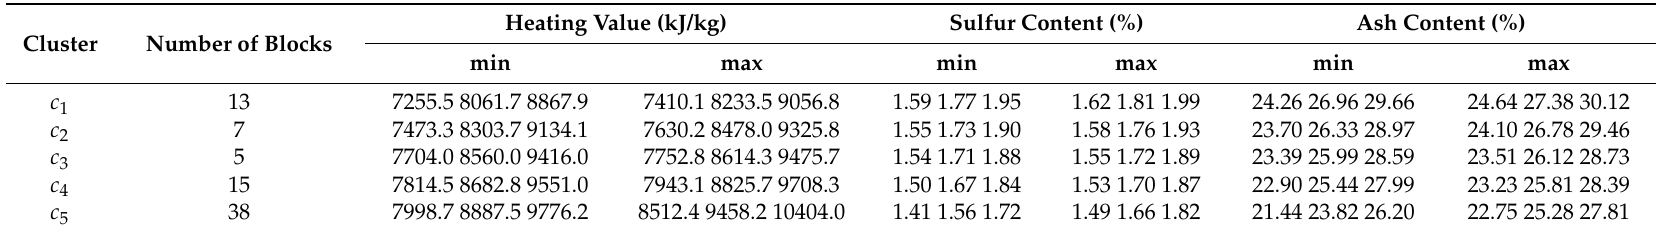
Table 6. Cluster’s fuzzy characteristics for a (78 × 4)